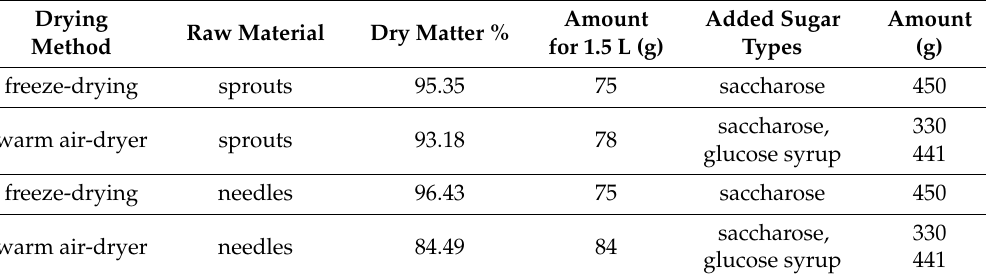
Table 7. Recipe for syrups of di ff erently dried Norway spruce sprouts and